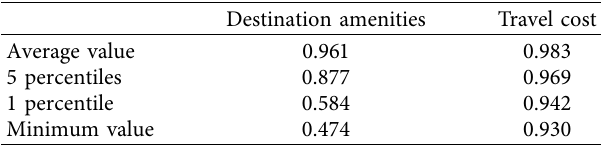
Table 4: Distribution of correlation coefcients between the destination value at one day and one of the all-time points